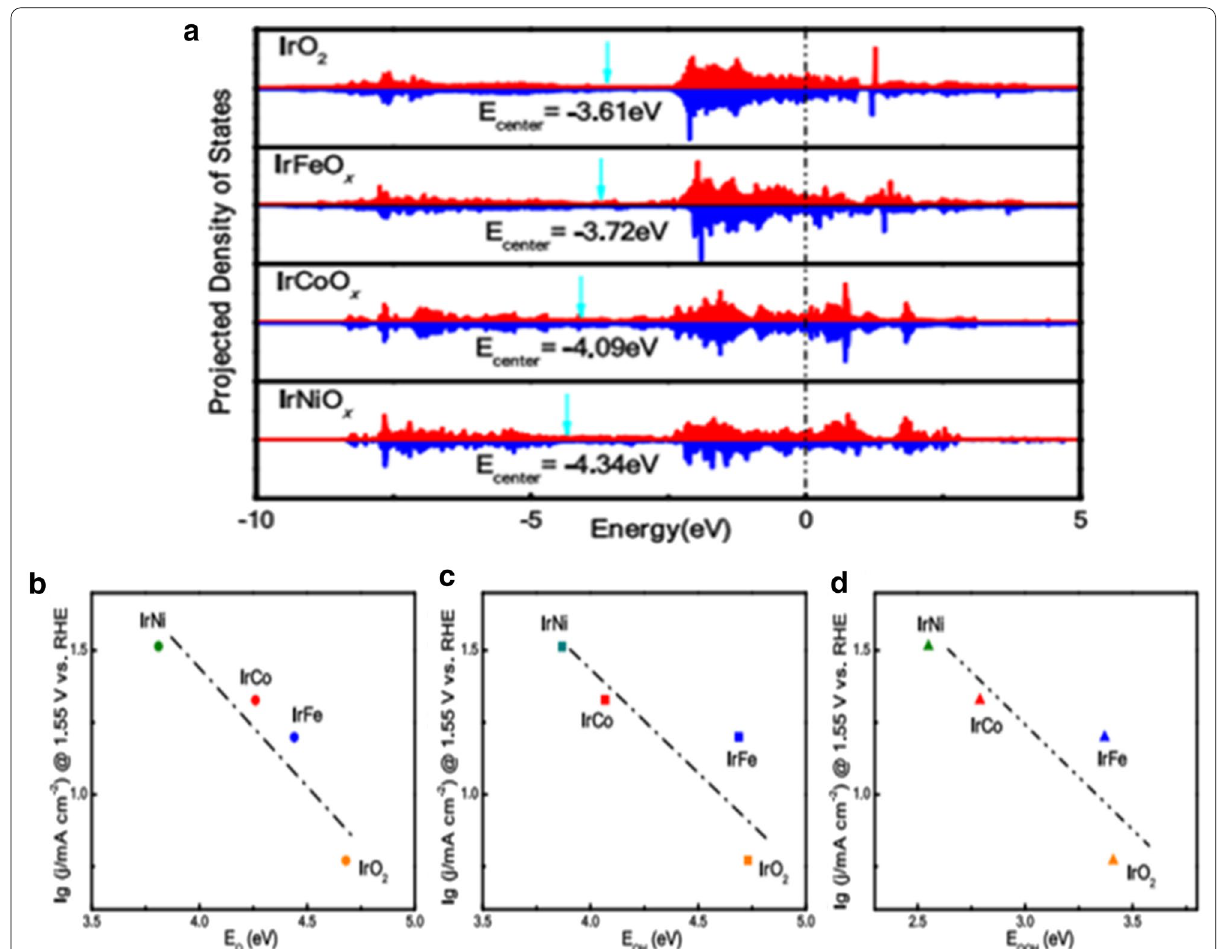
Fig. 11 a Projected DOS of Ir 5d bands of IrO 2 and IrMOx model. b – d Relationship between the activity (indicated by the logarithm of the as‑measured current density at 1.55 V vs. RHE) and the binding energies of different intermediate species: b O, c OH, and d OOH (Figure reprinted with permission from Ref.